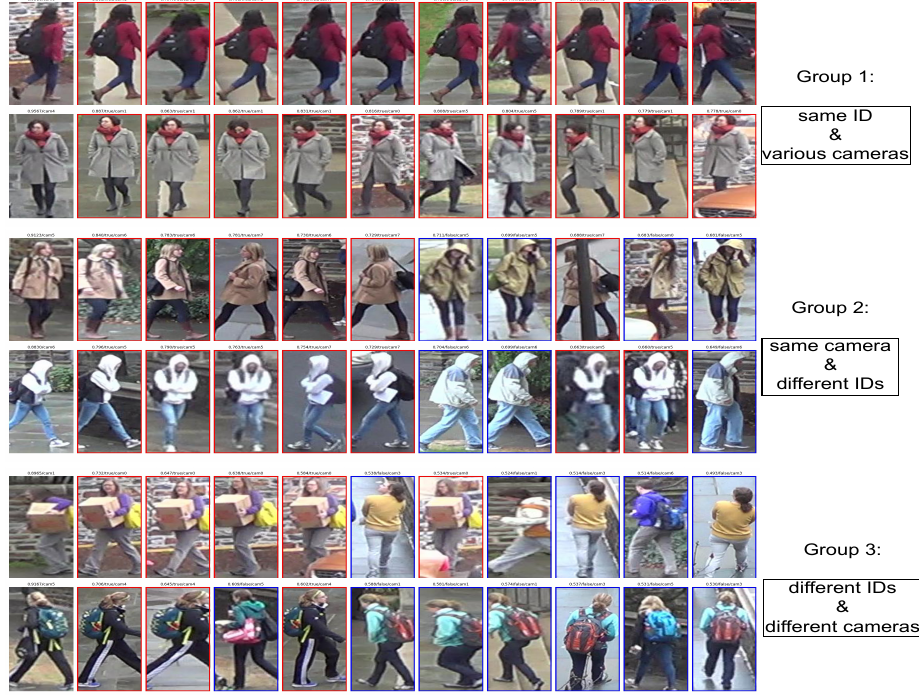
Figure 9. Retrieval ranking list. Compare the reliable confidence of samples by different similarities as upper and lower